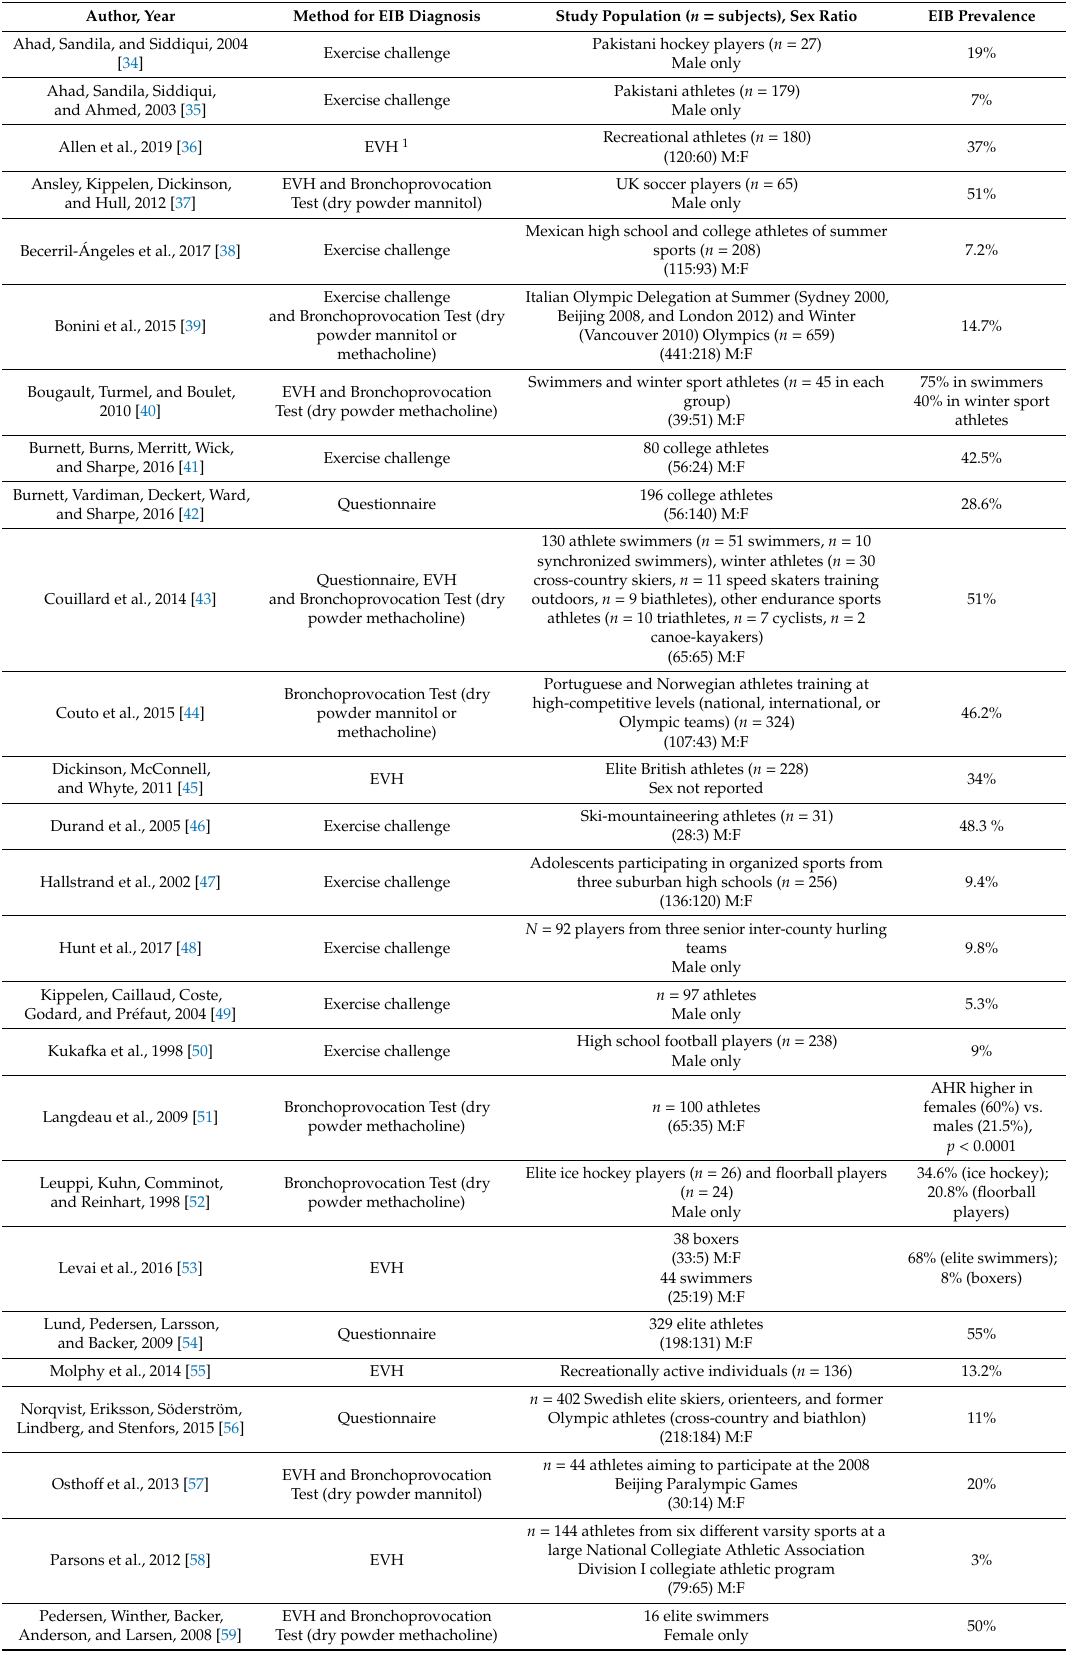
Table 1. Prevalence of exercise-induced bronchoconstriction (EIB) among male and female